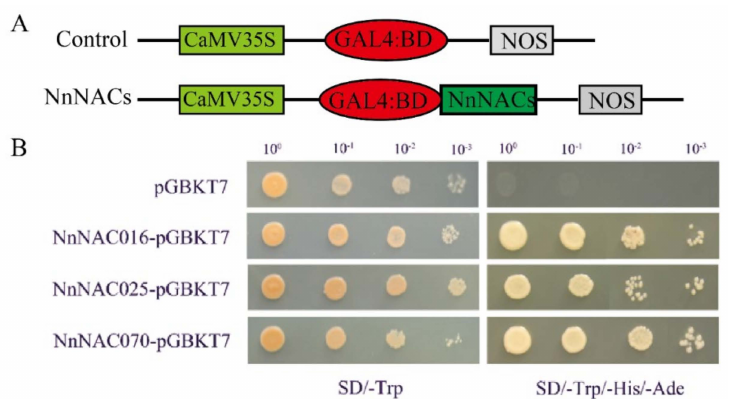
Figure 7. Transcription activation analysis of the three selected ANC proteins. ( A ) The diagram shows the structure of the fusion plasmid. ( B ) Transcription activation analysis of the nine selected NAC proteins. pGBKT7 was used as a negative